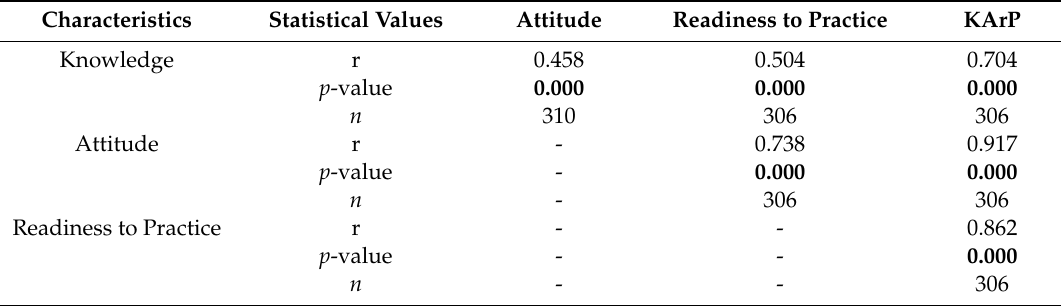
Table 4. Association between knowledge, attitude, and readiness to practice